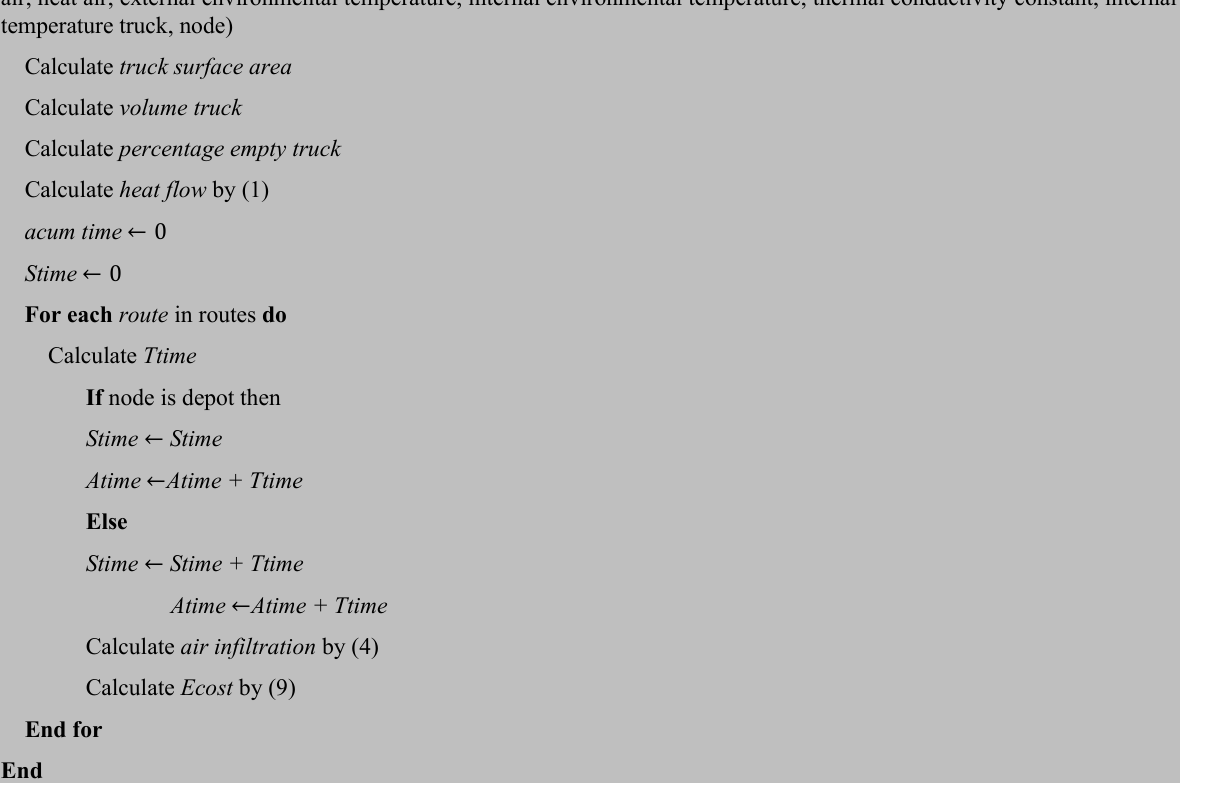
Algorithm 2. Energy Cost